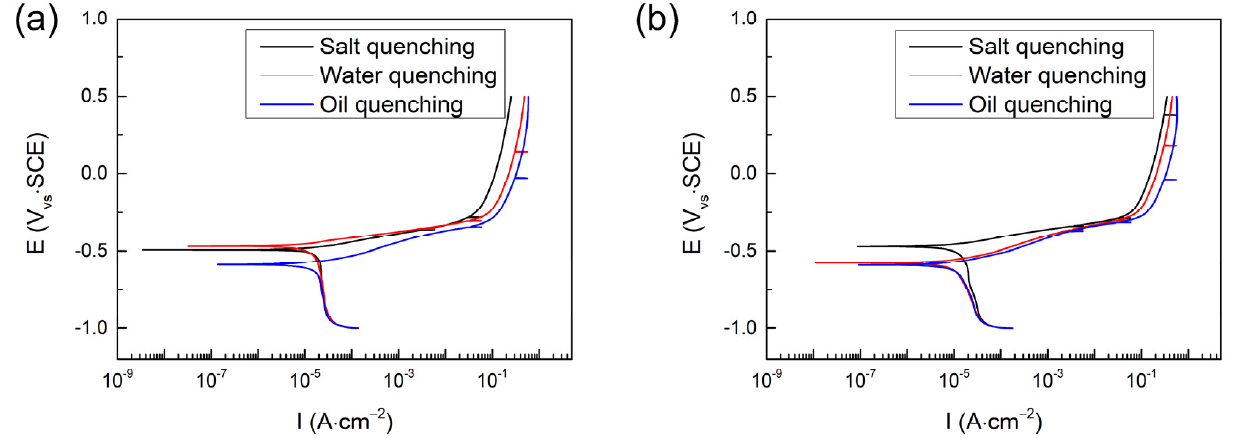
Figure 5. Potentiodynamic polarization curves for the samples quenched in the different quenching mediums in 10% NaCl solution: ( a ) traditional process, ( b ) CSP process.